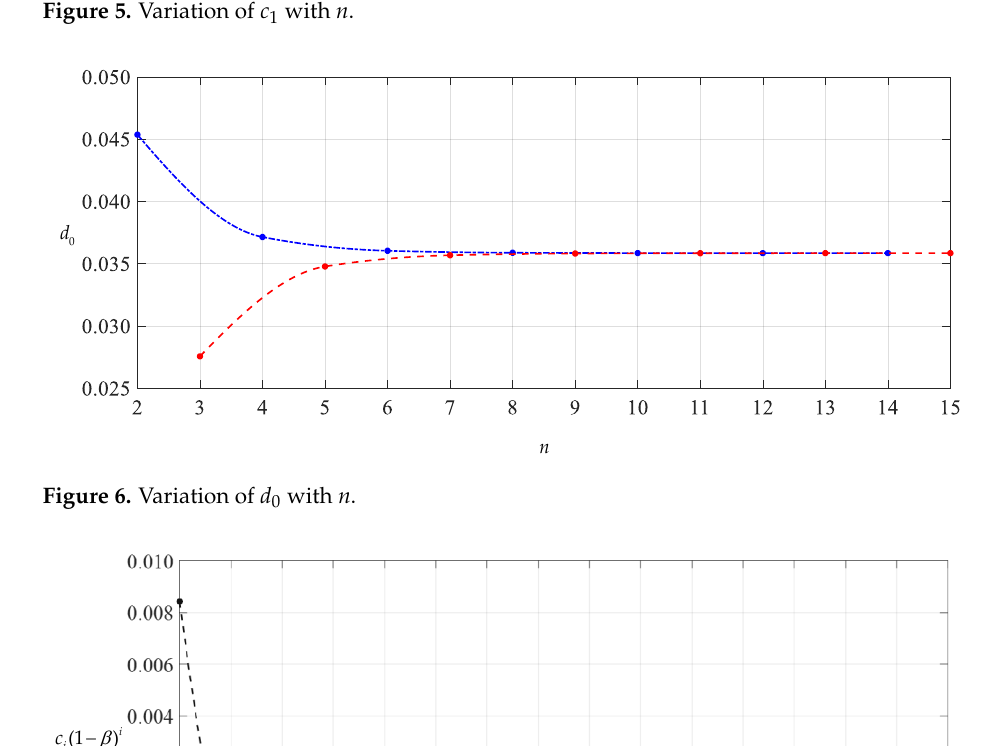
Table 3. Numerical values of d i (1 − β ) i and d i ( α − β ) i .